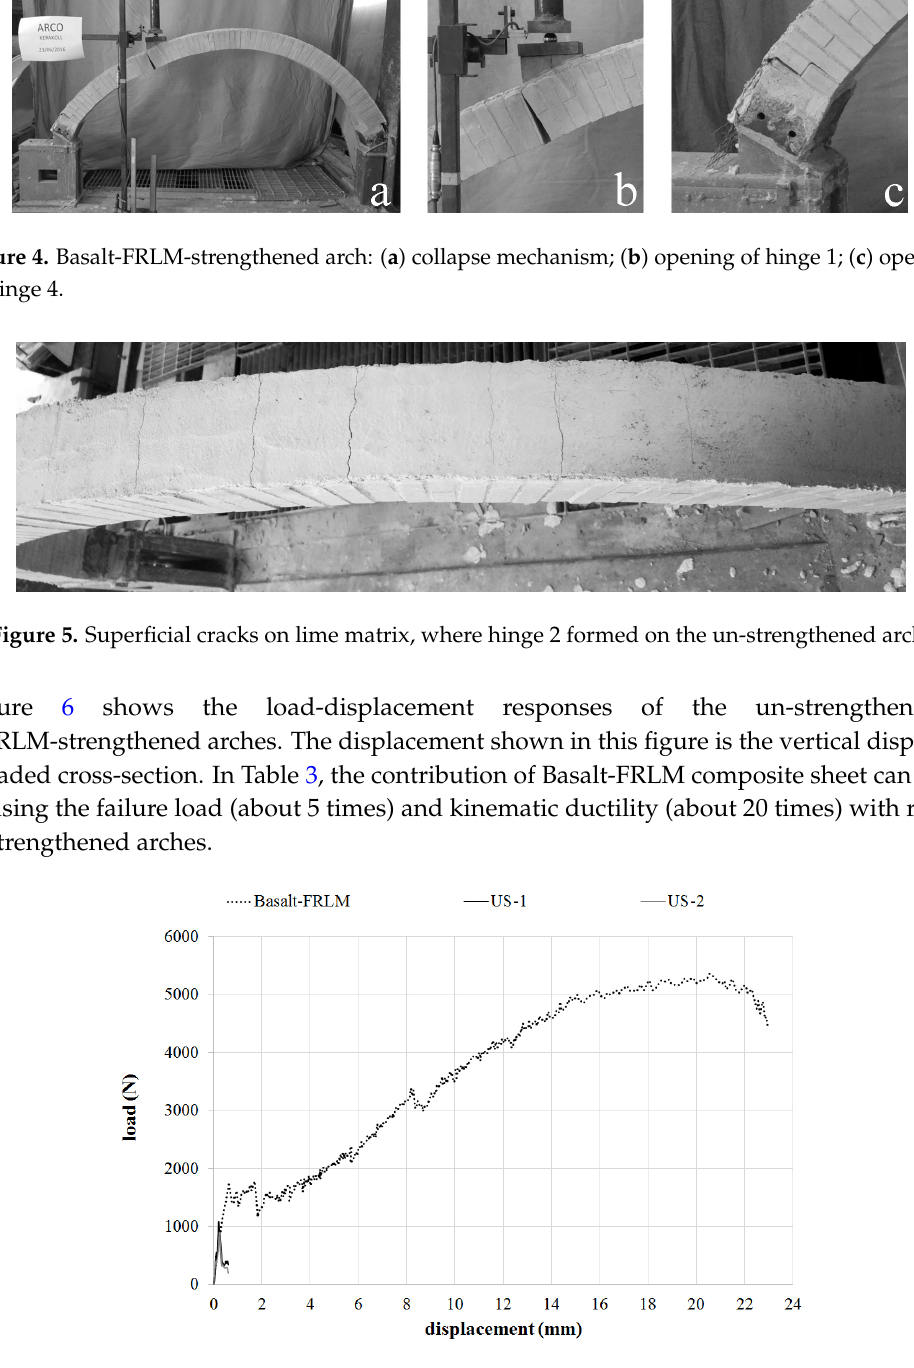
Figure 6. Load ‐ displacement curves of un ‐ strengthened and Basalt ‐ FRLM ‐ strengthened arch. Figure 6. Load-displacement curves of un-strengthened and Basalt-FRLM-strengthened